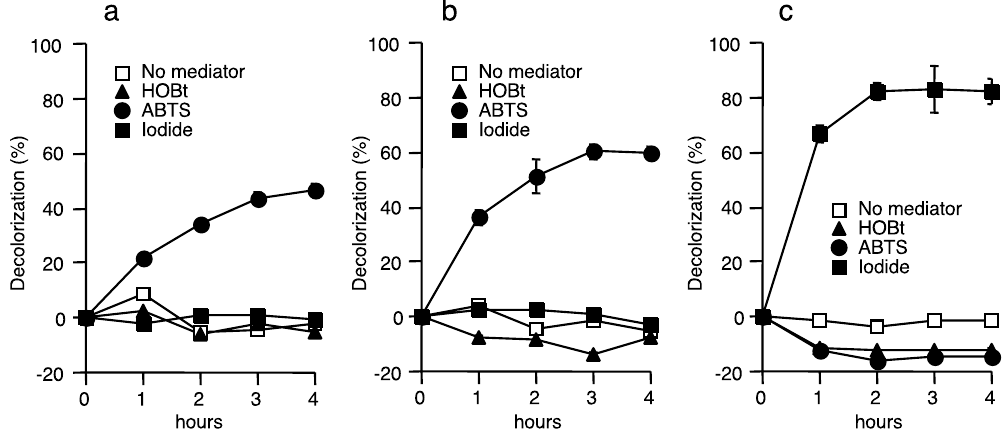
Figure 1. Decolorization of Orange G by TvL ( a ), PoL ( b ), and IOX ( c ) in the absence and presence of redox mediators. The reaction mixture contained 10 mU mL − 1 of enzyme, 0.3 mM Orange G, and 20 mM sodium acetate buffer (pH 5.0 for fungal laccases and pH 5.5 for IOX). Redox mediators used were 0.1 mM of ABTS, HOBt, and potassium iodide. Symbols represent the mean values obtained for triplicate determinations, and bars indicate standard deviations. In most cases, standard deviation values are smaller than those denoted by the